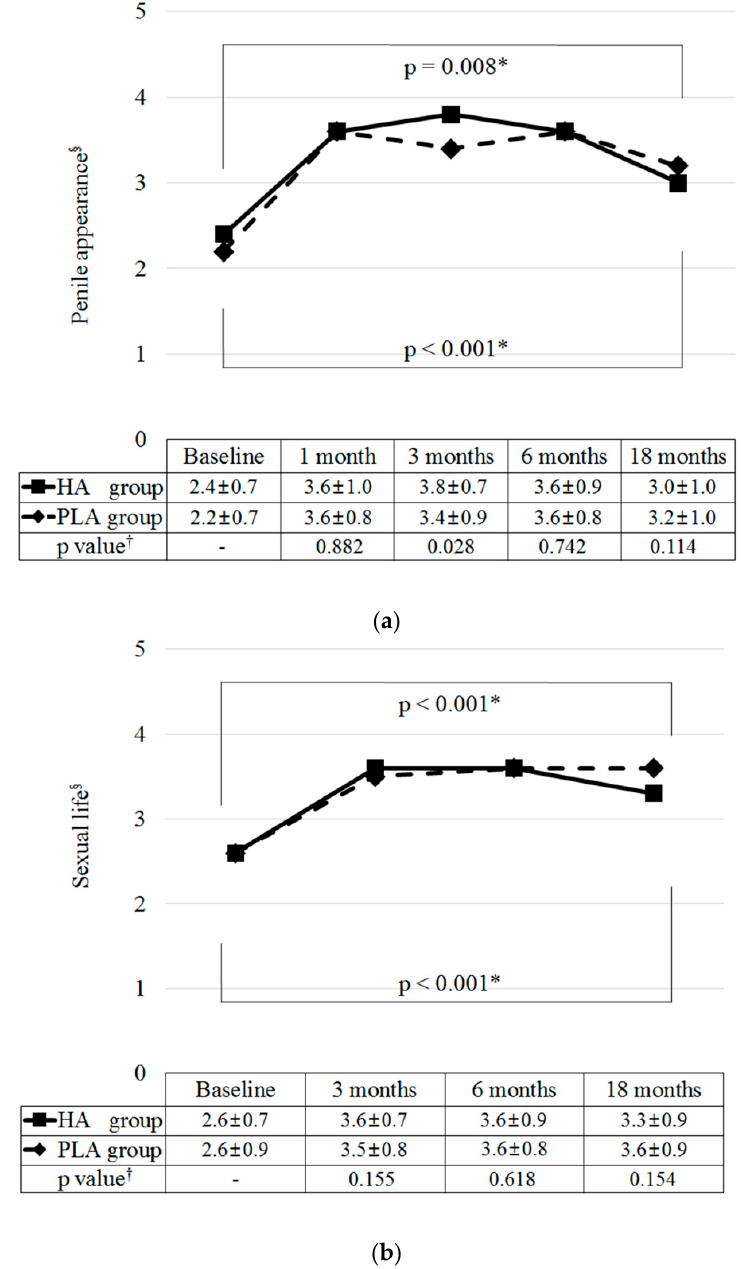
Figure 4. Changes of satisfaction associated with hyaluronic acid and polylactic acid filler injections: ( a ) penile appearance, ( b ) sexual performance. * Paired t-test. † Injected filler volume and baseline penile girth-adjusted analysis of covariance test from baseline. § Satisfactions were assessed with a 5-point visual analogue scale, with 1 indicating very dissatisfied and 5 indicating very satisfied. HA, hyaluronic acid; PLA, polylactic acid.